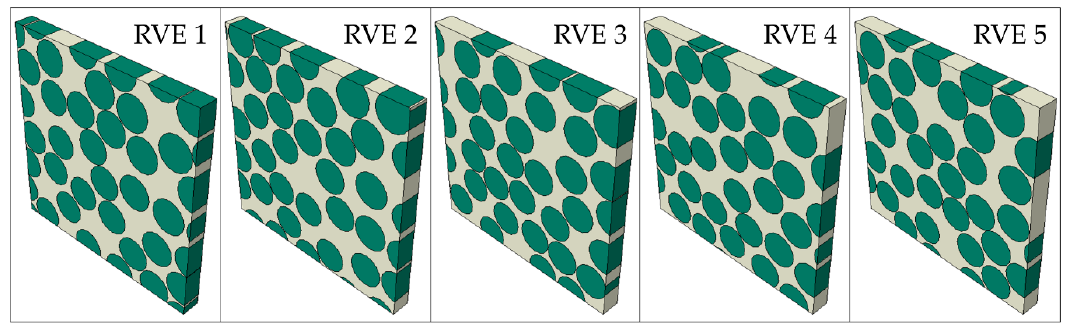
Figure 4. Finite element model of the RVE.